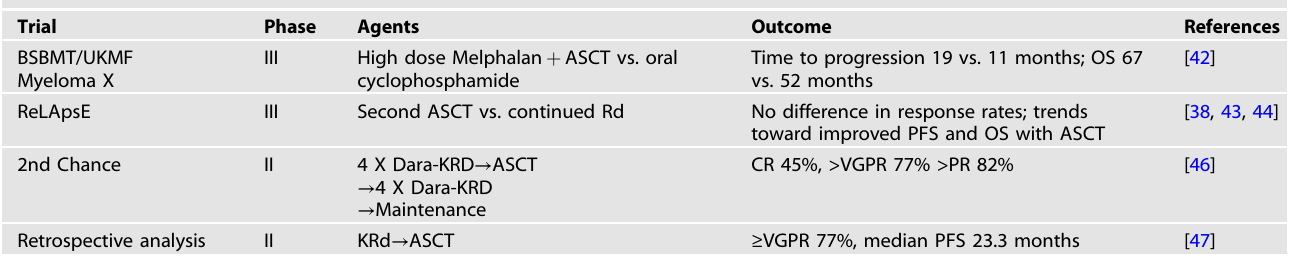
Table 2. Outcomes of trials of salvage